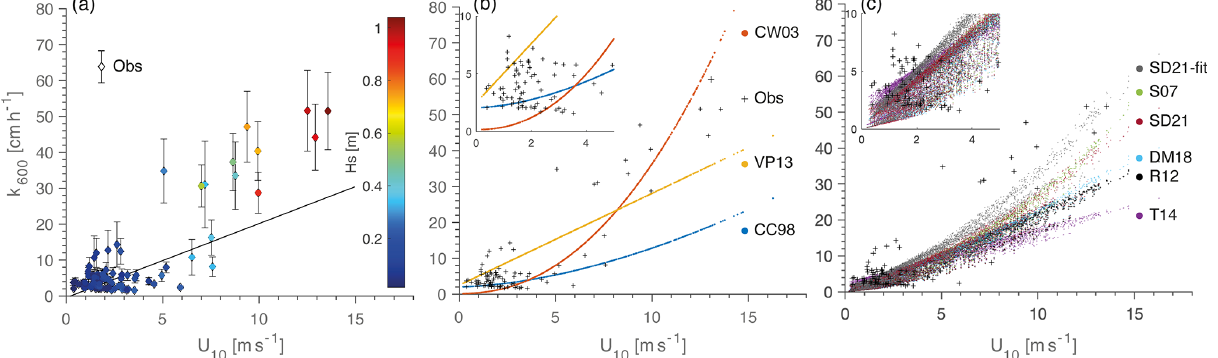
Figure 4. (a) k 600 observed as a function of U 10 and coloured according to H s (colour bar), showing the error bars produced by the uncertainty of (cid:49) CO 2 ( ± 50ppm) as well as the u ∗ − k 600 linear regression (solid line; see also Fig. B1); (b) k 600 wind-based models ( CC98 , CW03 , and VP13 ); (c) k 600 process-based models ( T14 , S07 , DM18 , SD21 , and SD21-fit ) computed with annual data. Observed k 600 derived from CO 2 flux chamber measurements is shown using the “ + ”